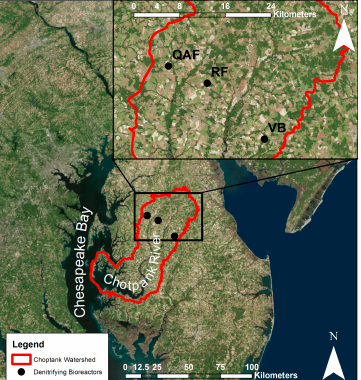
Figure 1. Location of bioreactor sites: QAF (Queen Anne Farm); RF (Ridgely Farm); VB (Voorhees Farm bioreactor).